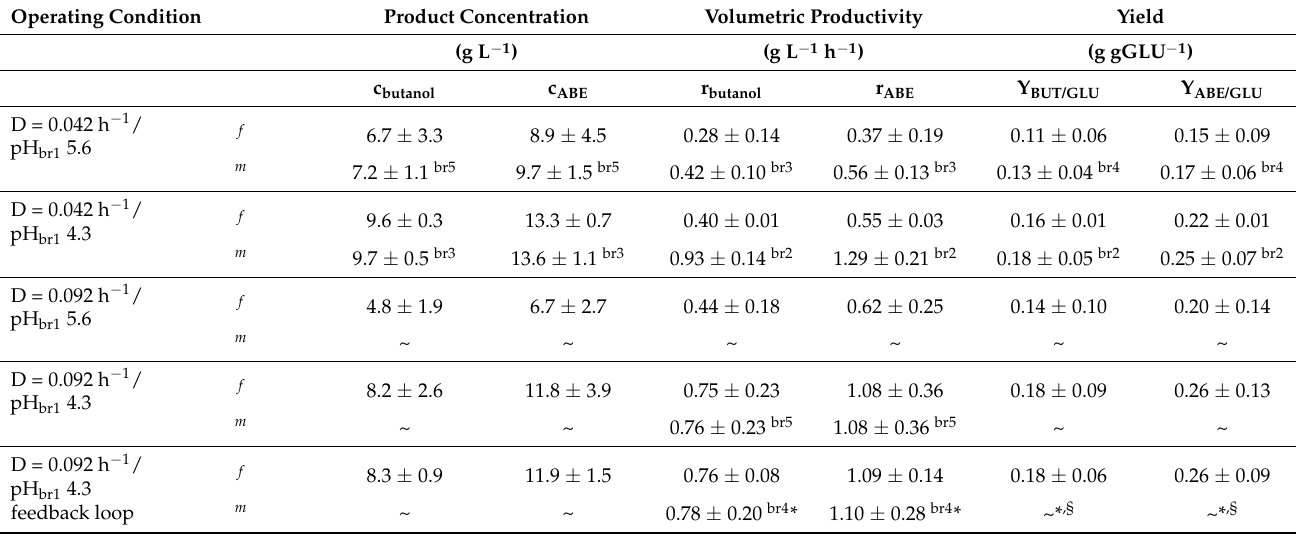
f values based on final concentrations in br6 (outflow of the cascade); m maximal values for individual bioreactors (corresponding bioreactors are indicated as br2 , br3 , br4 and br5 respectively); * values from br2 and br3 were not considered as the feedback loop cascade cannot be truncated at these bioreactor stages; § irrationally high values from br1 with equally high standard deviations were not